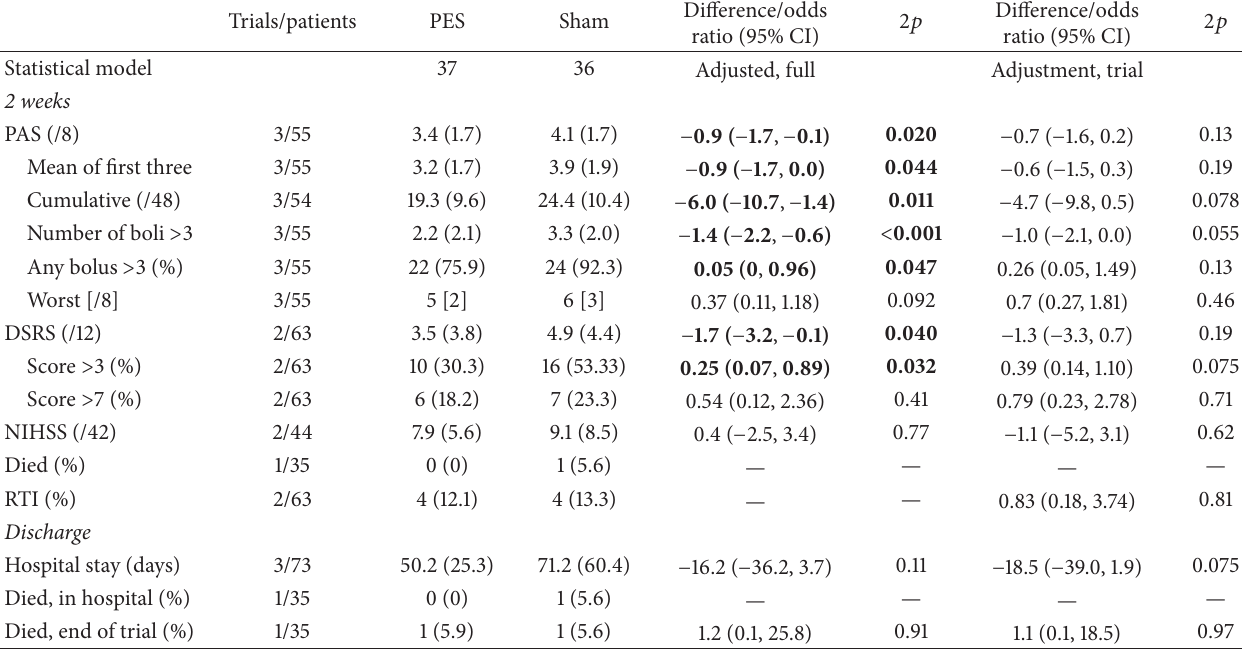
Table 3: Comparison of outcomes at 2 weeks and discharge from hospital in 73 patients across three trials by treatment assignment (pharyngeal electrical stimulation versus sham/placebo). Data are number (%), median [interquartile range], or mean (standard deviation). Comparison by binary logistic regression (BLR), ordinal logistic regression (OLR), or multiple regression (MR), with 95% confidence intervals. Adjustment: full model is adjusted for trial, relevant baseline score, age, and impairment (NIHSS); partial model is adjusted for trial only.